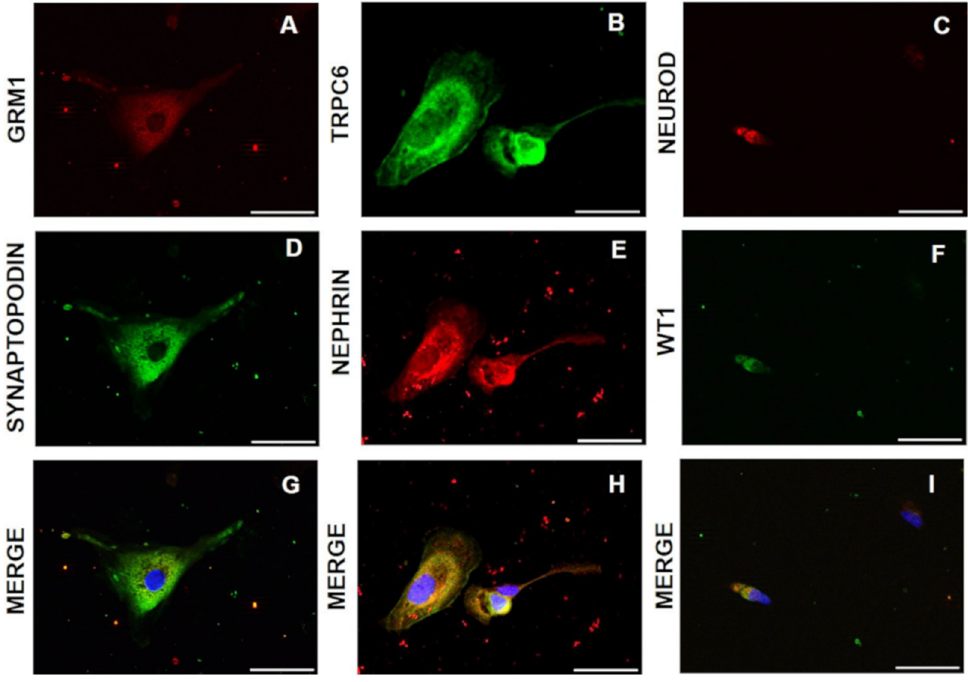
Figure 1. Staining of functional molecules in urinary podocytes. GRM1, TRPC6, and NEUROD ( A – C ) double staining with, respectively, synaptopodin, nephrin, and WT1 ( D – F ); Merge between A–C and D–F ( G–I ) cytoplasmic and nuclear podocyte markers were detected in urinary podocytes. DAPI Nuclear staining (blue) shows the absence of apoptosis. Scale bar is 100 µm.